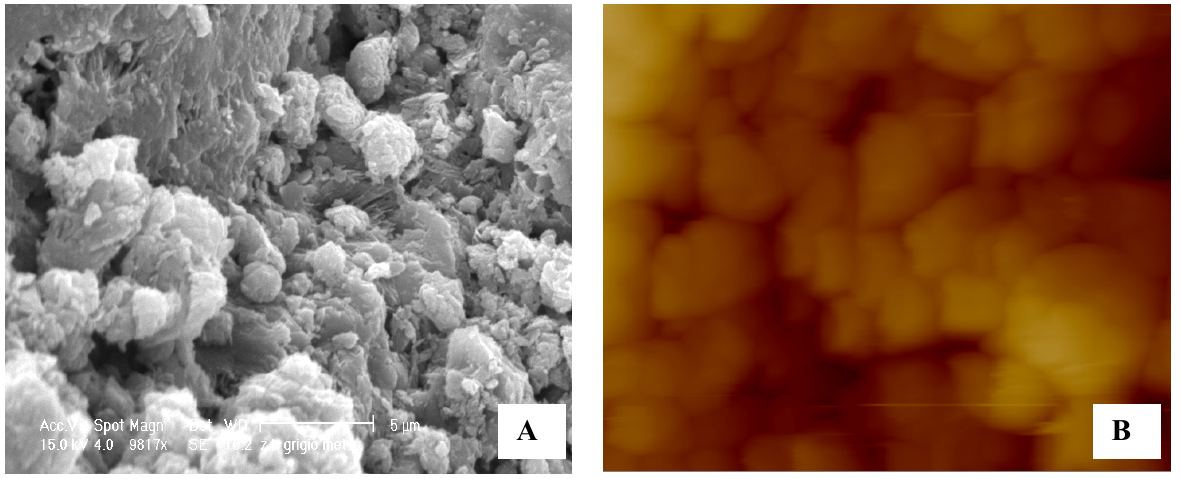
Figure 5. Comparison between AFM and scanning electron microscopy (SEM). A and C show a photomicrograph highlighting the presence of clusters of granules. In B and D , the AFM image of the same zeolites matrix powder. All the measures were carried out at the same full scale of 20 µm for better